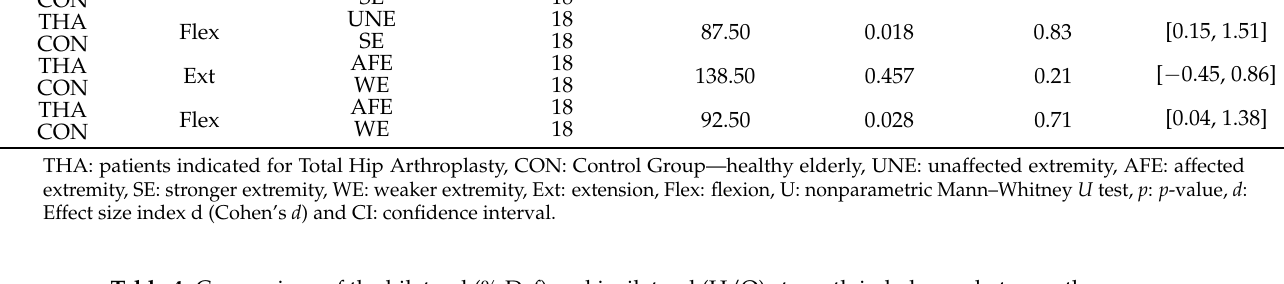
Table 4. Comparison of the bilateral (% Def) and ipsilateral (H/Q) strength imbalances between the groups. Muscle